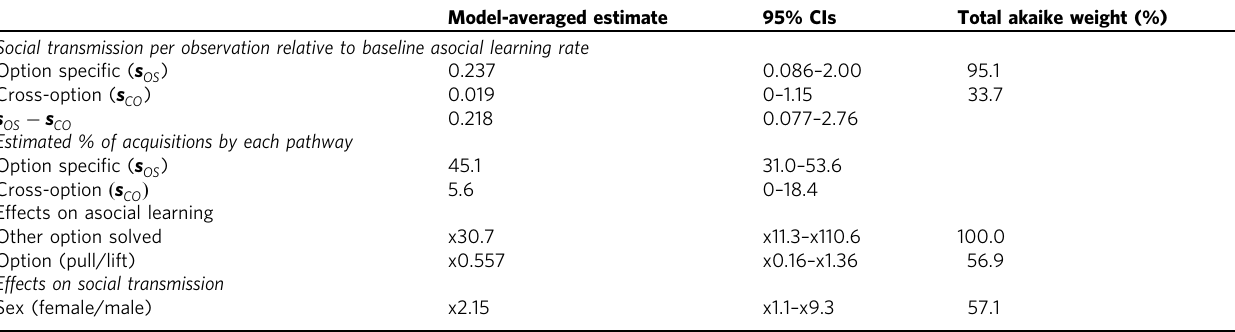
Table 2 NBDA aim 1: detecting and quantifying social